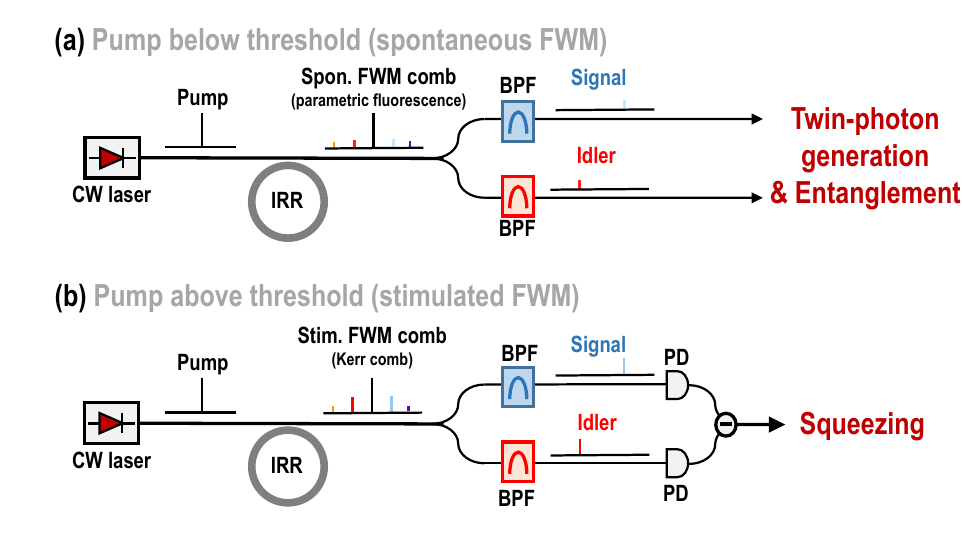
Figure 9: (Color online) Simplified experimental setups for the analysis of the quantum states of Kerr combs. (a) Pump below threshold. The setup allows to investigate parametric fluorescence and entangled photon pair generation. (b) Pump above threshold. The setup permits to investigate quantum correlations and two-mode